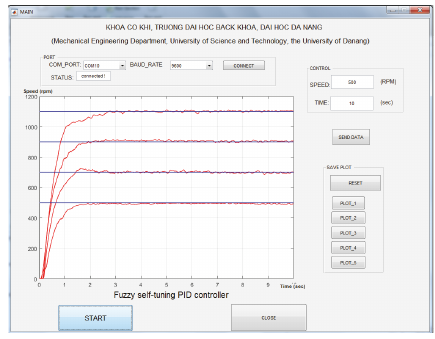
Figure 13: Experimental result on Matlab/Guide.